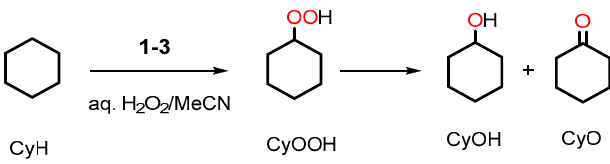
Table 4. Total yield (cyclohexanol and cyclohexanone) with time in the oxidation of cyclohexane by